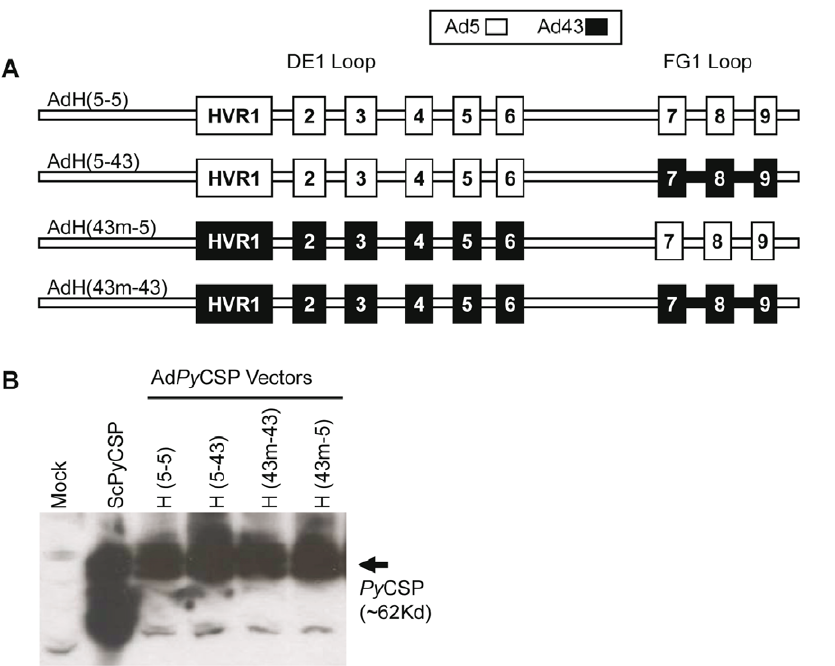
Figure 2. Ad5 vectors containing hexon hypervariable regions from Ad43 express Py CSP transgene efficiently. Generation of Ad5 vectors with hypervariable regions of Ad43. A. Schematic showing the DE1 and FG1 loops of the unmodified Ad5 vector and three chimeric vectors containing Ad43 HVR substitutions in the FG1 loop, DE1 loop and both loops as indicated. B. Western blot showing the expression of the Py CSP antigen following infection of A549 cells with 200 pu/cell of purified vectors. Mock represents an uninfected cell lysate and serves as a negative control. ScPyCSP represents purified Py CSP protein from Saccharomyces cerevisiae and serves as a positive control. Hexon designations are indicated above the associated well (H=hexon) and the serotype source of the DE1 and FG1 loops shown in parentheses (DE1–FG1). Immunoblots were probed with antibody specific for Py CSP.